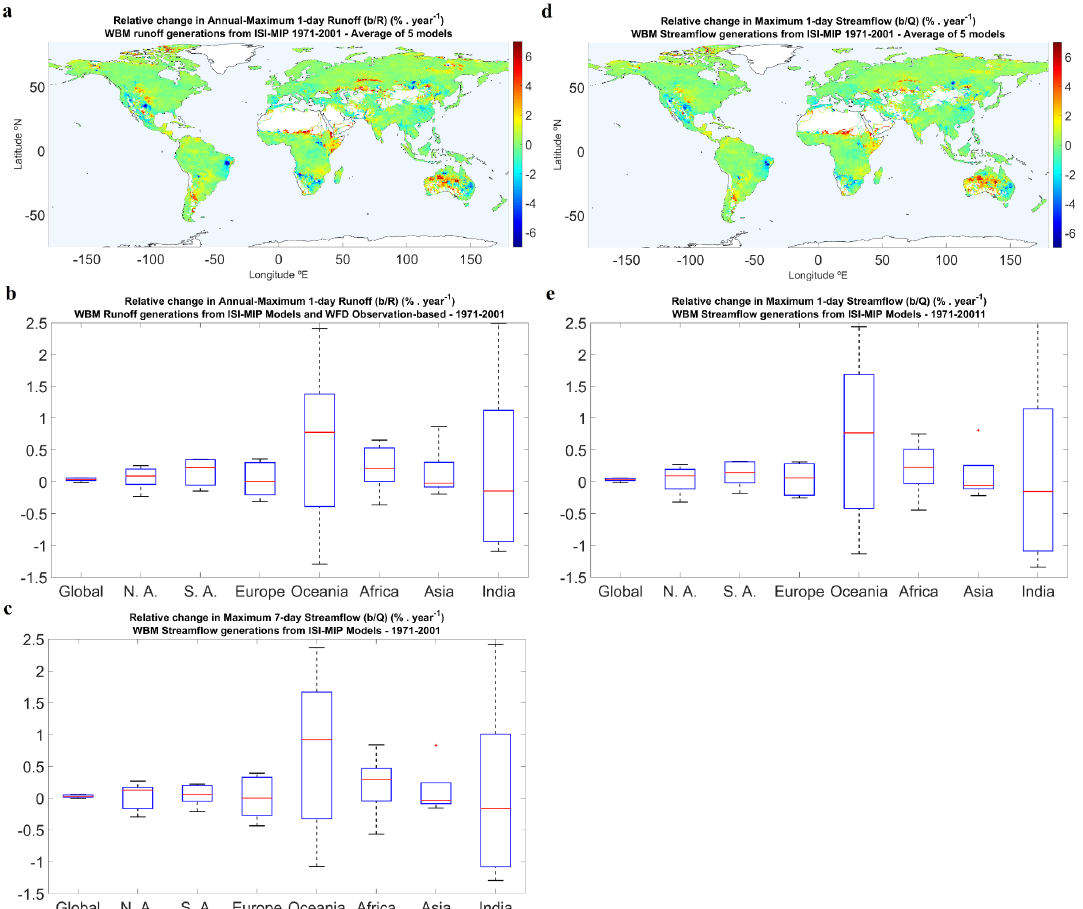
Figure 6. ISI-MIP global map of relative change in extreme runoff ( a ) and extreme streamflow ( d ). Boxplots of trends simulated under climate forcing from ISI-MIP models (minimum, 25th percentile, median, 75th percentile and maximum of the 5 model runs) for relative change in annual-maximum 1-day runoff (%·year − 1 ) ( b ), annual-maximum 1-day streamflow (%·year − 1 ) ( e ) and annual-maximum 7-day streamflow (%·year − 1 ) ( c ).